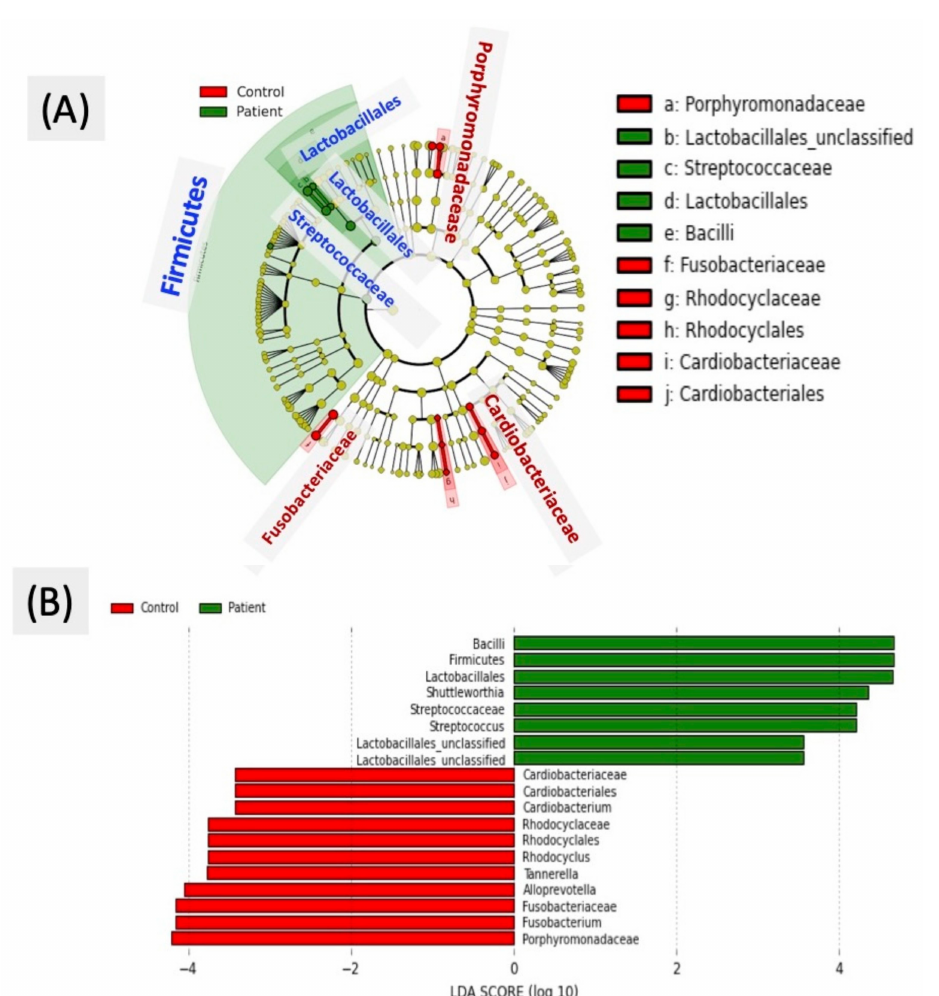
Figure 5. Linear discriminant analysis effect size (LEfSe) was used to identify the most differentially abundant taxa in the AD and control groups ( A ) Taxonomic cladogram of the 16S sequences. The brightness of each dot is proportional to its effect size. ( B ) The taxa that were abundantly found in the elderly control group are indicated with a negative linear discriminant analysis (LDA) score (red), and AD group with a positive score (green). Only the taxa that met a significant LDA threshold value of > | ± 3| are